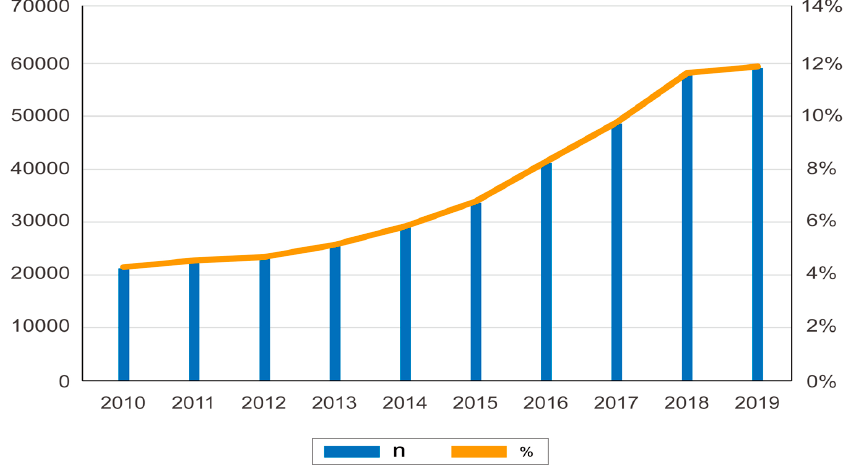
Figure 3. Annual incidence and prevalence of polycystic ovarian syndrome in Korea ]